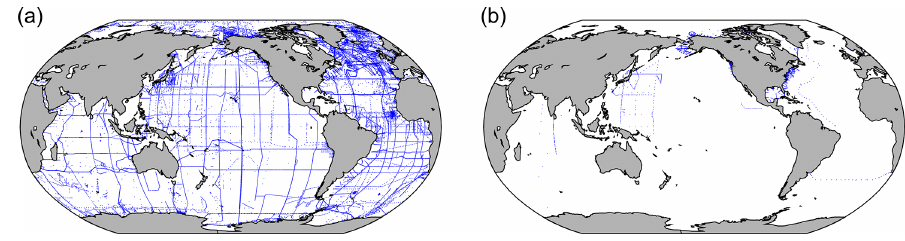
Figure 1. Location of stations in (a) GLODAPv2.2021 and for (b) the new data added in this